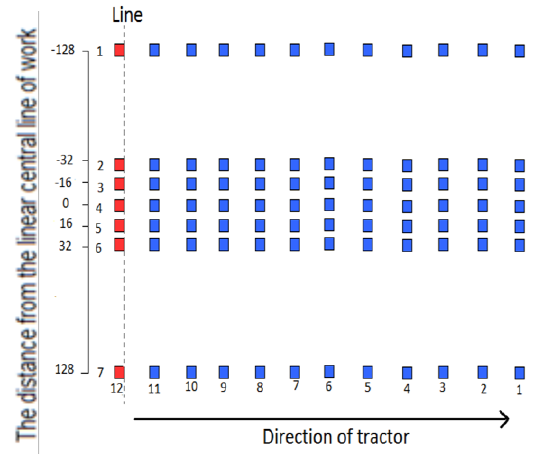
Figure 8. Different views of the DC engine and the gearbox Figure 10. Arrangement of seed collection matrix and command mounted on the Hassia seed drill; a) The engine, b) the gearbox, line location to change the seed and c) the coupling of the gearbox axle to the axis of the gearbox